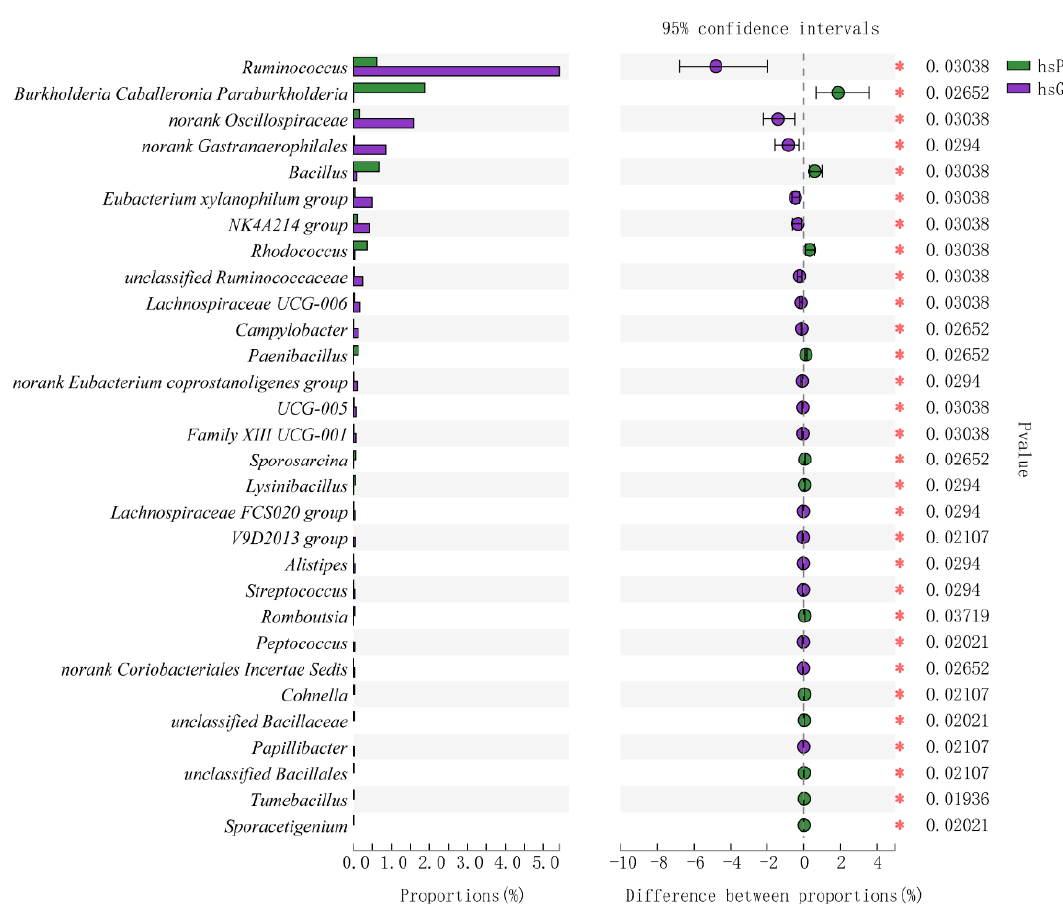
Figure A2. Wilcoxon rank–sum test bar plot at the genus level for the comparison of the microbiota in the stomach. The relative abundances of 30 genera were tested and found to be significantly different between the hsP and hsG groups. * 0.01 < p < 0.05.